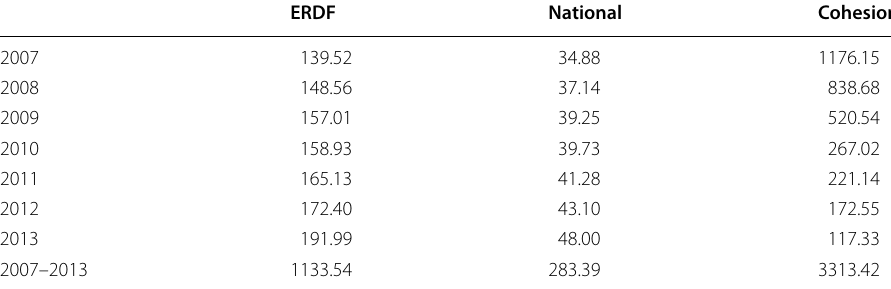
Table 3 Total funds (in million euros). Source Spain: operational program “cohesion fund‑ ERDF” & INE